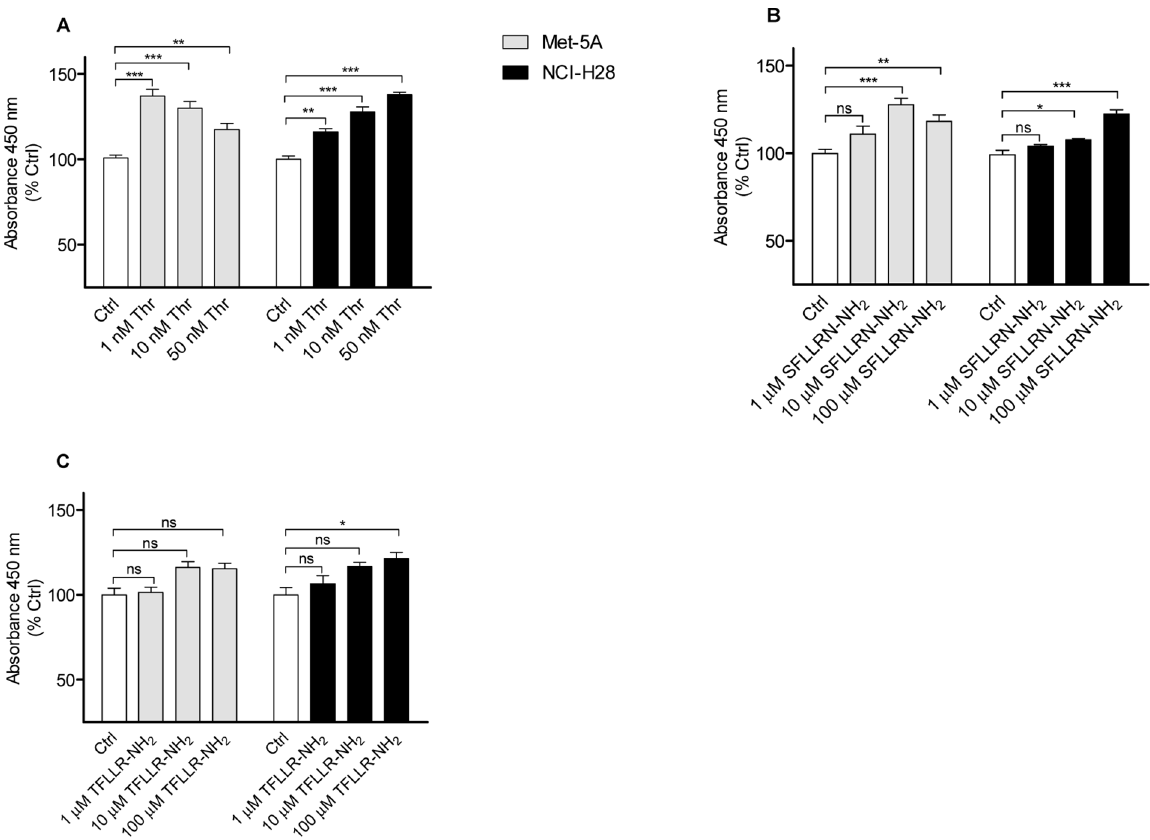
Figure 2. PAR 1 agonists enhance Met-5A and NCI-H28 cell proliferation. Met-5A and NCI-H28 cells were serum and growth factor starved for 18 h and then treated with different concentrations of agonists for 72 h. Cell proliferation was measured using a mitochondrial activity assay (WST-1). The optical density values of vehicle treated Met-5A and NCI-H28 cells (Ctrls) were 0.210 6 0.03 and 0.232 6 0.04 (n=6; ns by Student’s t test), respectively. A, thrombin-induced cell proliferation (n=6); B, non-selective PAR 1 -AP-induced cell proliferation (n=6); C, selective PAR 1 -AP-induced cell proliferation (n=3). Data shown are mean 6 SEM of at least three independent experiments performed in triplicate. The differences in proliferation between Ctrl and agonist-treated cells were significant (*P # 0.05, **P # 0.01, ***P # 0.001) by one-way ANOVA followed by Bonferroni’s multiple comparison test.